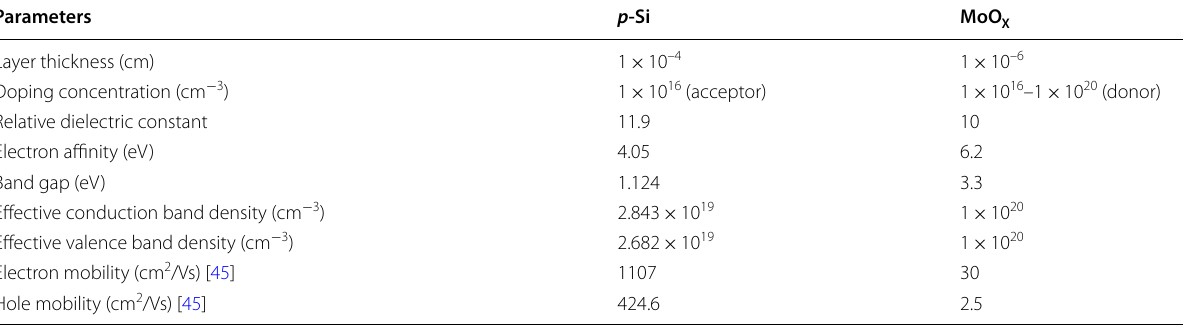
Table 1 Parameters used for AFORS-HET simulation